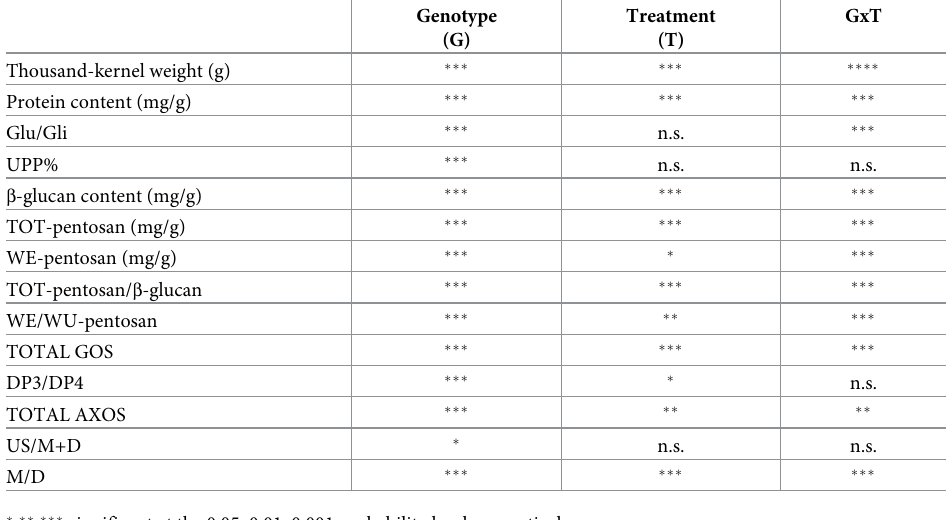
Table 1. Significance of the main effects and their interactions for grain compositional traits tested with Linear Mixed Model